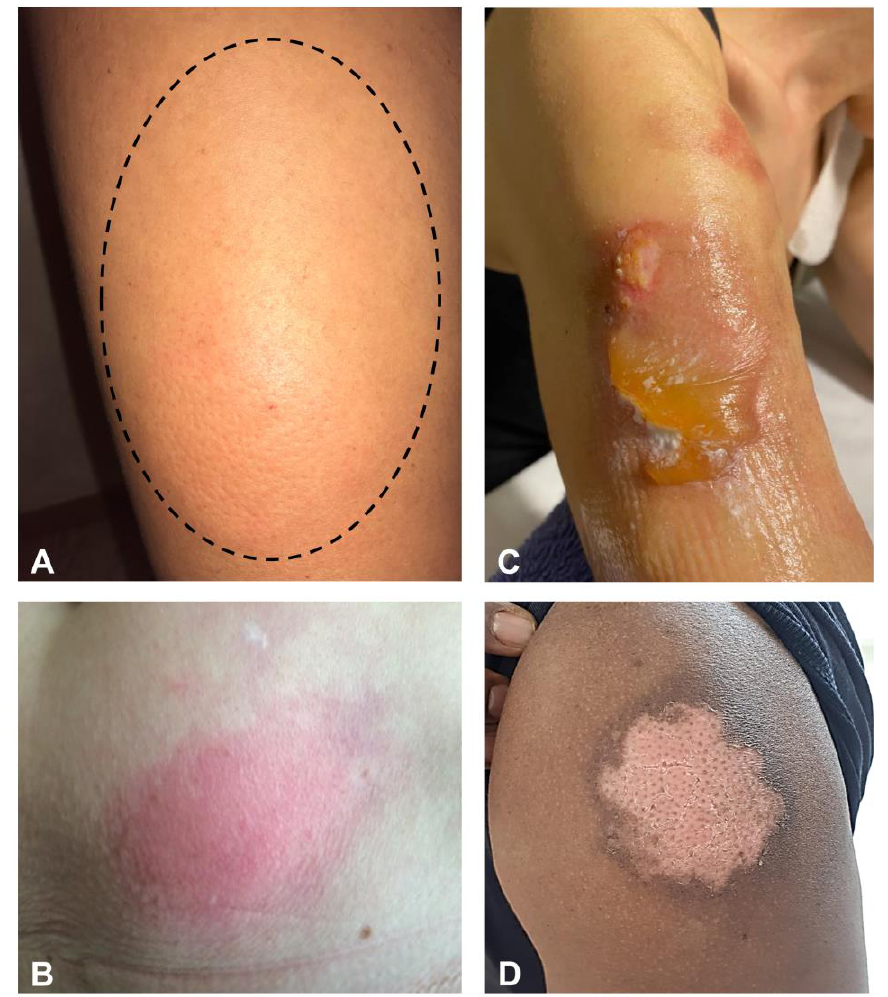
Figure 2. Edematous ( A ) and erythematous ( B ) indurated and tender plaques in the site of the injection developed one week after BNT162b2 vaccination in 36- and 67-year-old females, respectively. Burning bullous reactions on the deltoid area after the application of an ice pack to relieve the pain in a 56-year-old woman ( C ). Depigmented erythematous plaque of the deltoid skin developed in a 39-year-old African man three weeks after BNT162b2 vaccination ( D ).